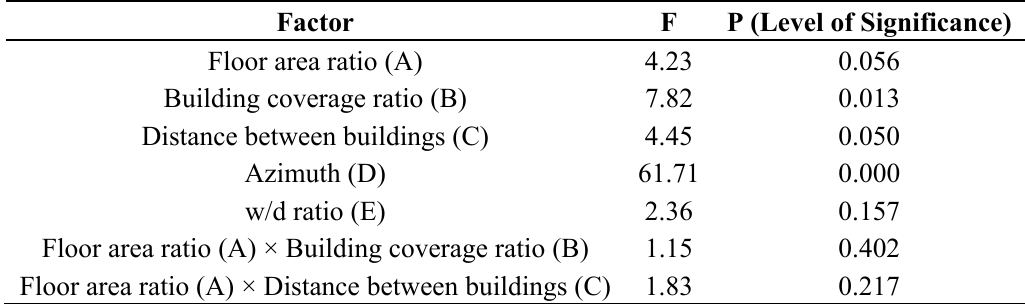
Table 5. Significant probability analysis by design of experiments